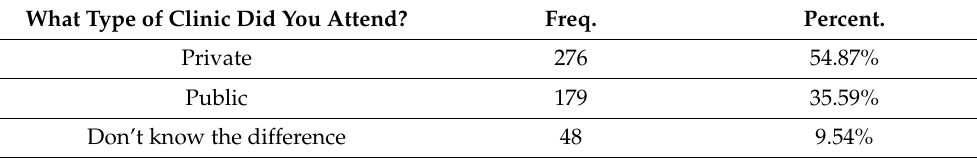
Table 7. Type of dental